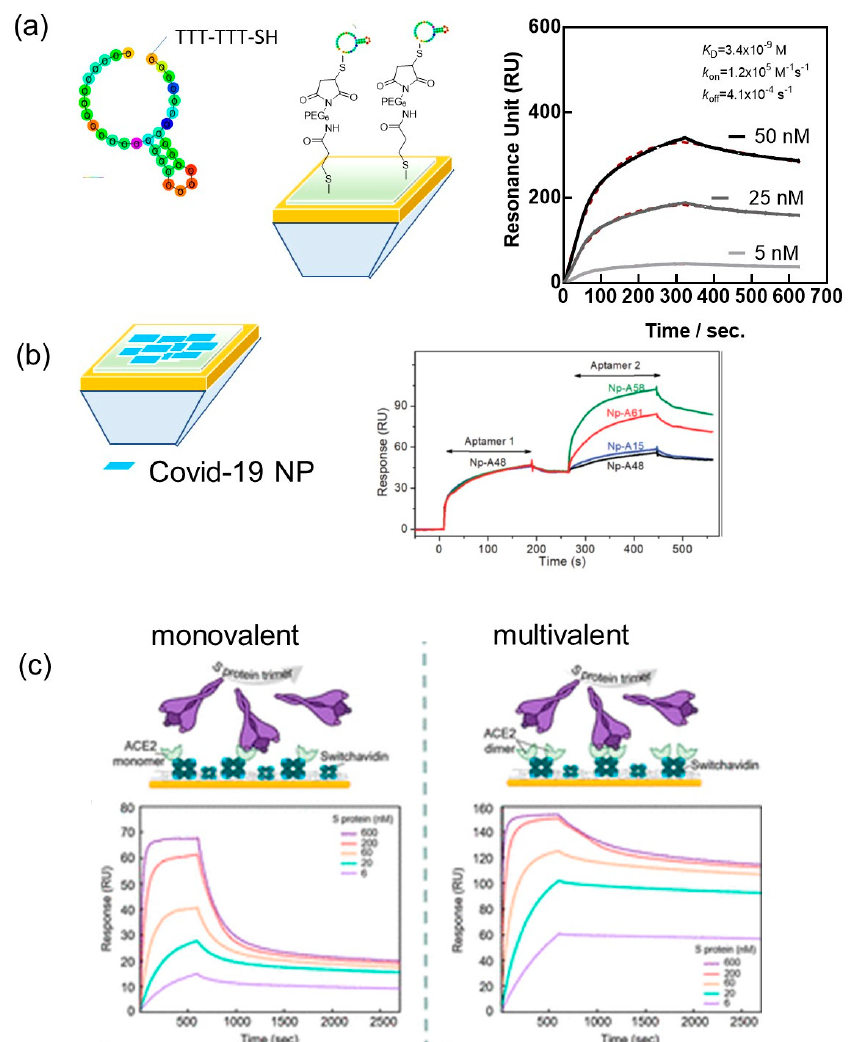
Figure 3. SPR as a valuable tool for the determination of affinity between SARS-CoV-2 bioreceptors and viral proteins: ( a ) SPR sensogram of the binding kinetics for S1 spike protein to 20-base aptamer “CFA0688T” from BasePairBio together with surface chemistry architecture. ( b ) SPR sensograms of the binding kinetics of N-protein specific aptamers to SARS-CoV-2 N-protein modified SPR chips (CM5 chip using EDC/NHS chemistry) with a sequence of different aptamers flown over the sensor chip (Reprinted with permission from Ref. [41]), 2020, RSC, ( c ) Schematic of SPR assay on monolayer and dimer ACE-2 modified SPR chips together with binding kinetics (Reprinted with permission from Ref. [42], 2021, ACS).